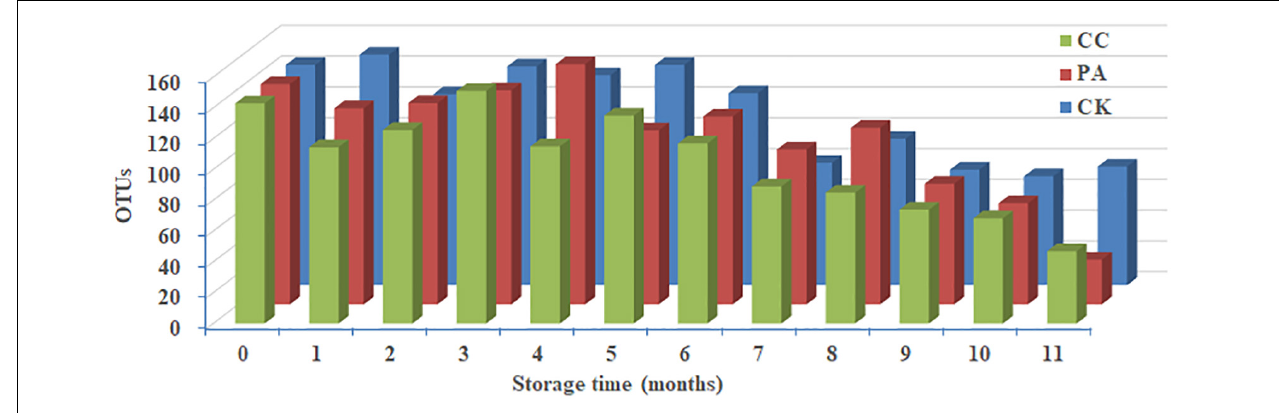
FIGURE 2 | Predicted number of operational taxonomic units (OTUs) per sample in stored maize. CK, control group; PA, propionic acid group; CC, complex essential oils